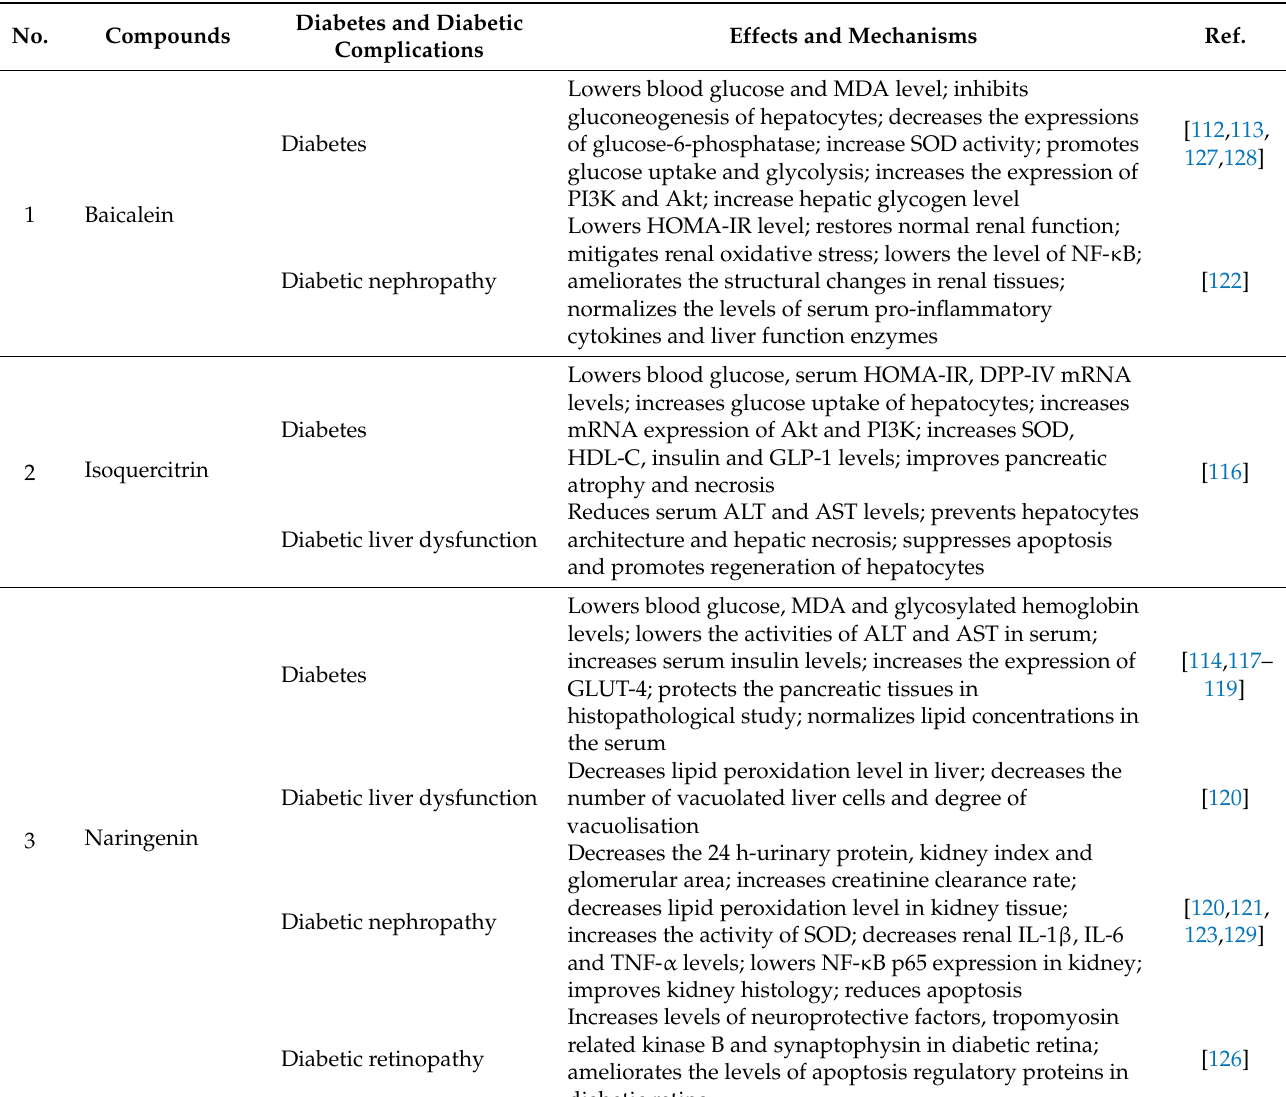
Figure 3. Structures of flavonoids with antidiabetic effects; ( 1 ) Baicalein, ( 2 ) Isoquercitrin, ( 3 ) Narin- genin, ( 4 ) Prunin and ( 5 ) Sinensetin. Table 3. The effects and mechanisms of some flavonoids in O. stamineus in the treatment of diabetes and diabetic